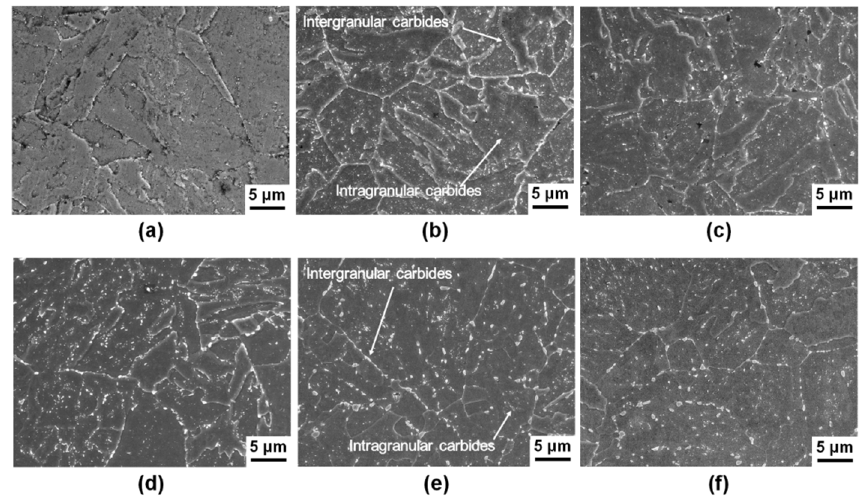
Figure 4. SEM micrographs of ( a ) the as-received steel and after aging at 600 °C for ( b ) 100, ( c ) 300, ( d ) 1000, ( e ) 6000 and ( f ) 7000 h.